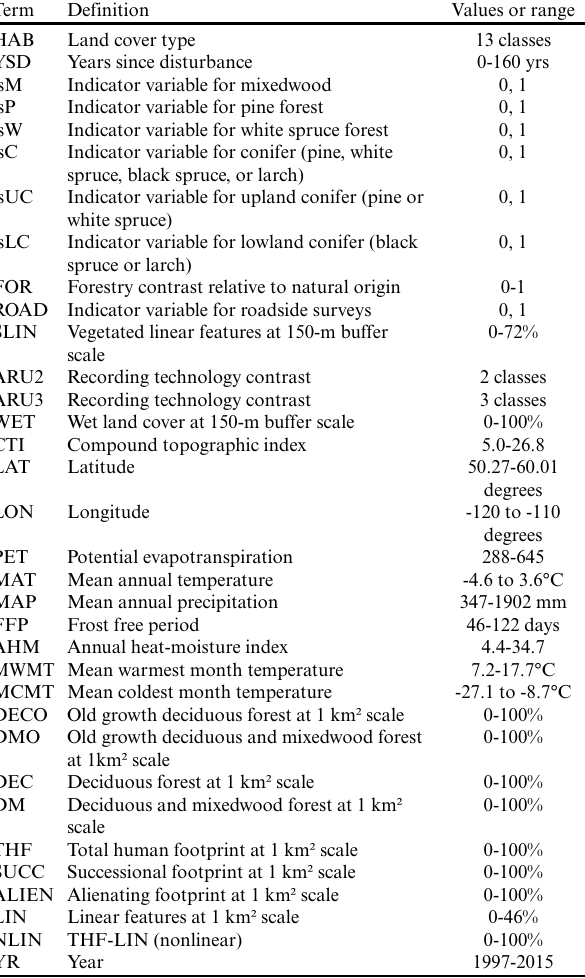
Table 1 . Definition of model terms that were selected at least once in modeling with the range of values in the data set.